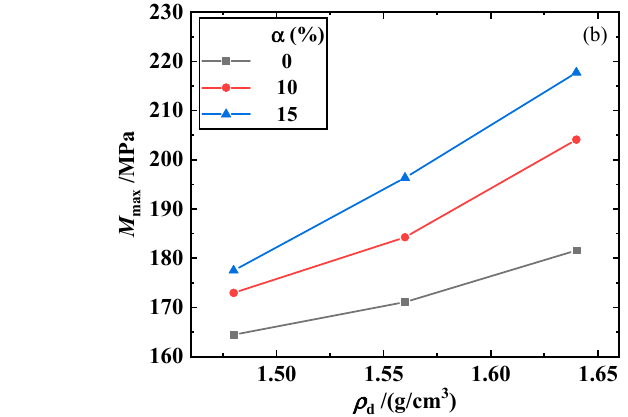
Figure 6. Relationship between G max , M max , and dry density, ρ d , of the biochar–clay mixture: ( a ) G max - ρ d ; ( b ) M max - ρ d .